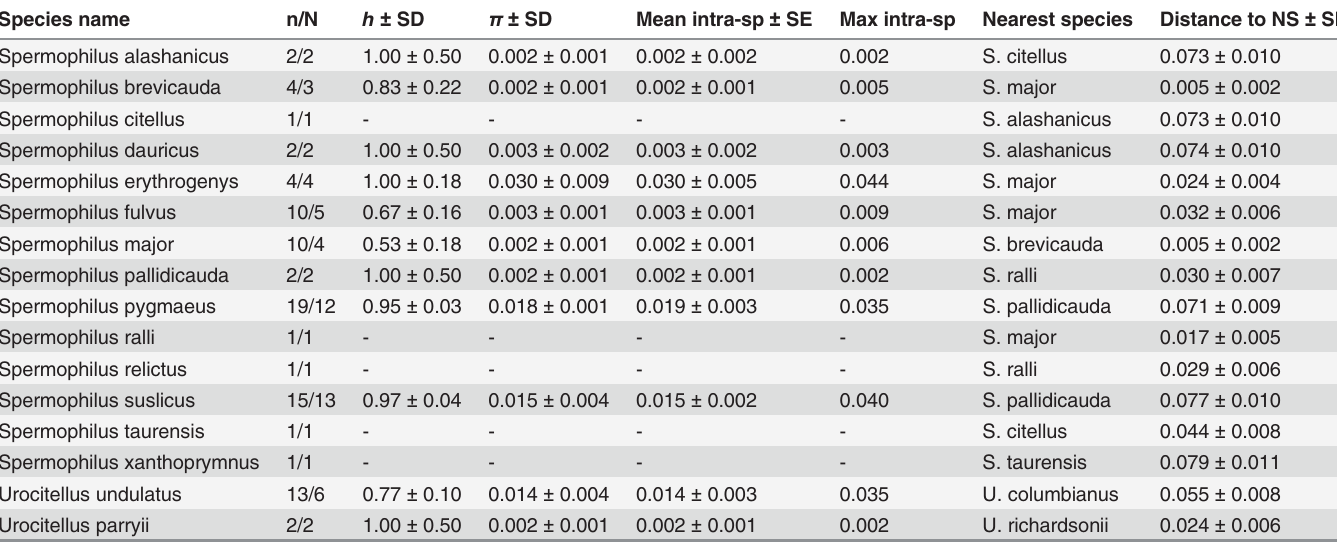
Table 1. Intraspeci fi c genetic variation of Eurasian Ground